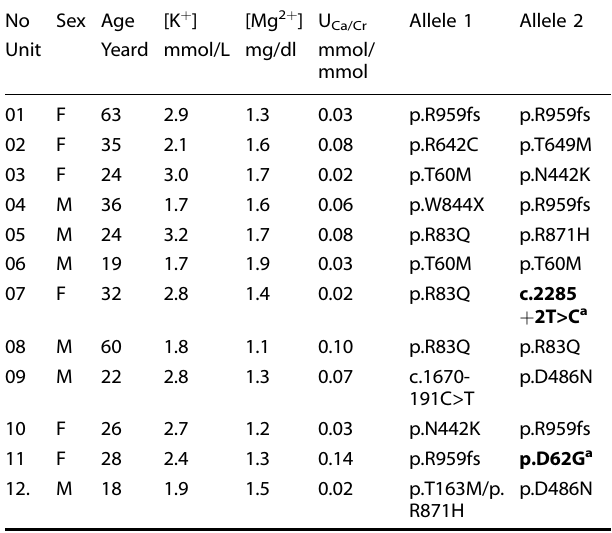
Table 2. Recurrent mutation-based detection in clinically diagnosed GS